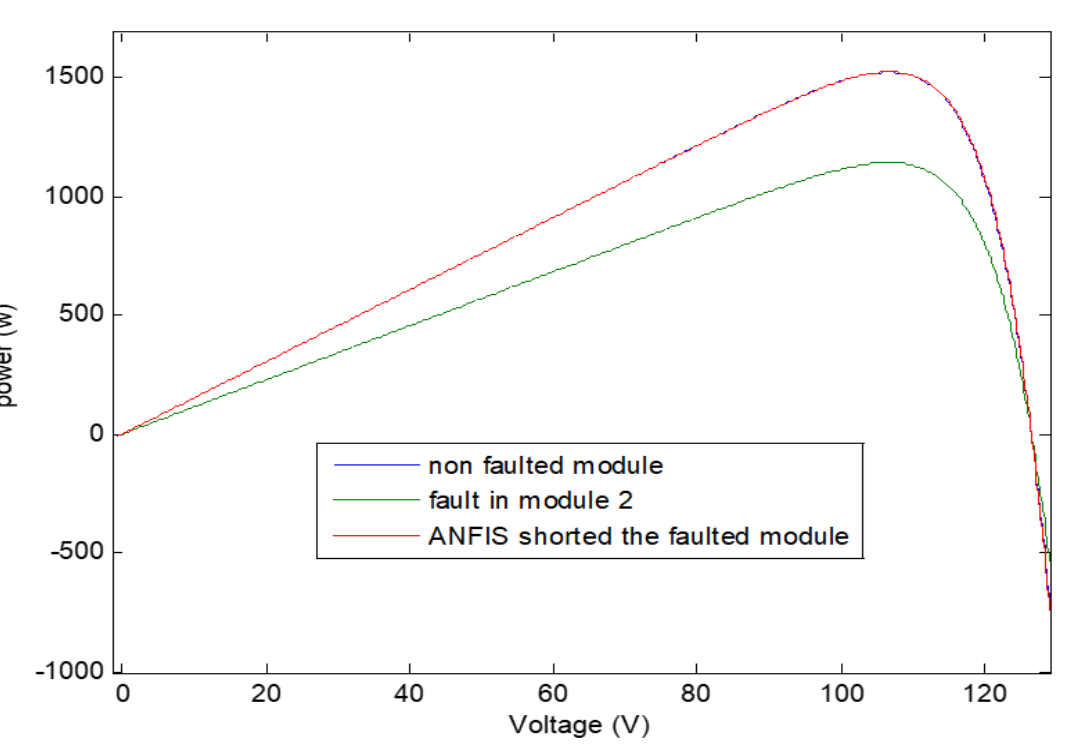
Figure 11. Effect of open-circuit fault occurred in a certain group on the power output of PV array.